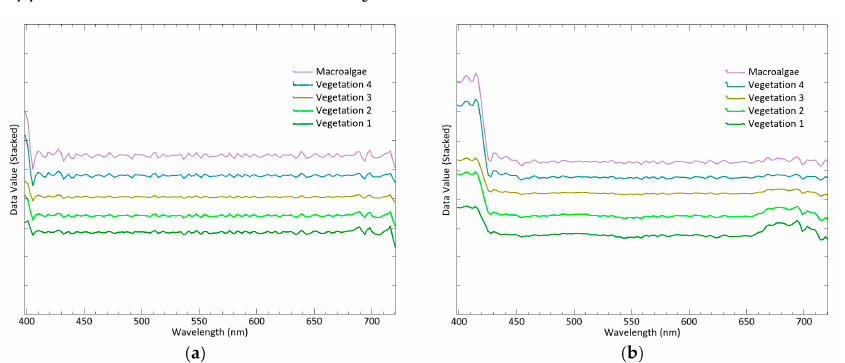
Figure A1. The focus is on the VIS region of the electromagnetic spectrum. The main peaks can be identified in the 2nd derivative spectrum of the five studied spectral signatures ( a ). The boxcar average smoothing filter applied on the 2nd derivative spectrum highlights other important peaks for the studied signatures ( b ). Significant peaks are present at wavelengths where pigments influence the spectral response of vegetation: 427,472, 487, 512, 547, 576, 638, 676, 689, and 698 nm.